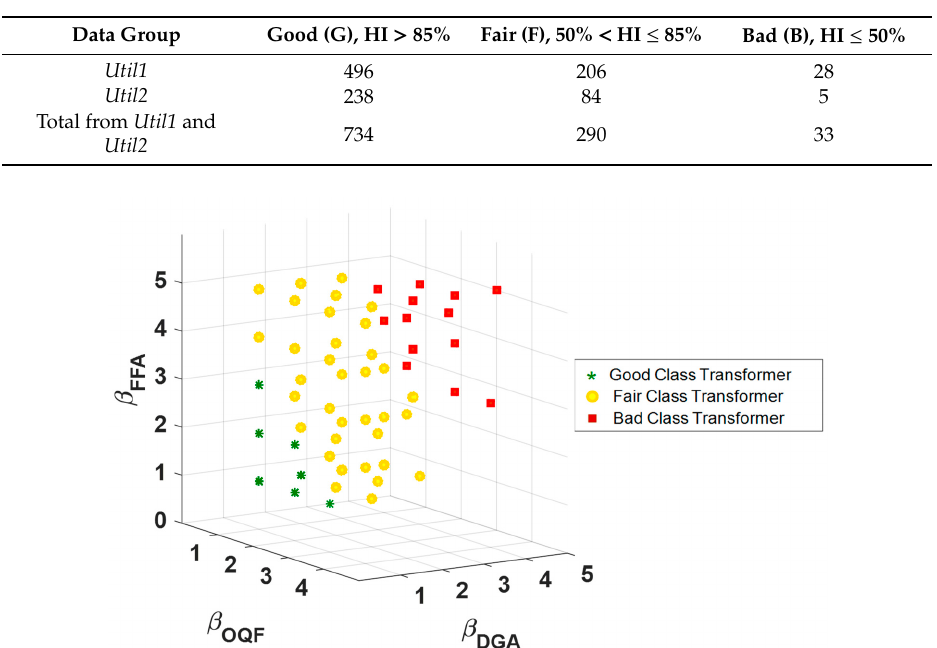
Table 1. Health index value range of health condition classes and the corresponding number of samples.